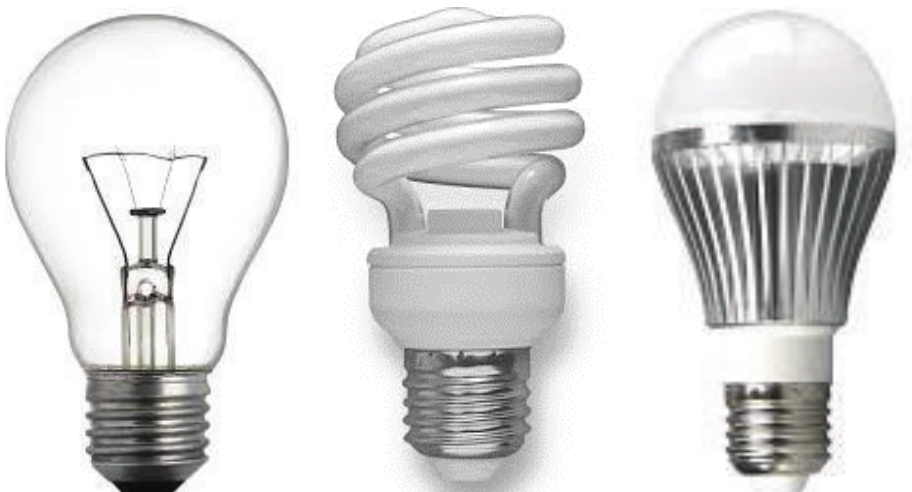
Figure 1: Incandescent, CFL, and LED light bulbs.